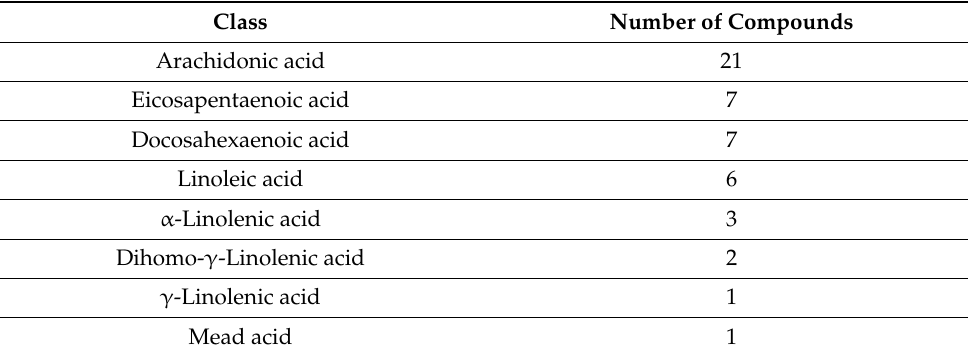
Figure 1. LC-MS/MS chromatogram of 48 oxylipins performed on a triple quadrupole employing dynamic MRM( n = 10). MRM metabolite detection multipeak diagram showed the substances that could be detected in the sample, with the mass spectrum peak of each color representing one metabolite detected. Table 1. Oxylipins detected in feces of suckling piglets from 3d to 21d after birth.